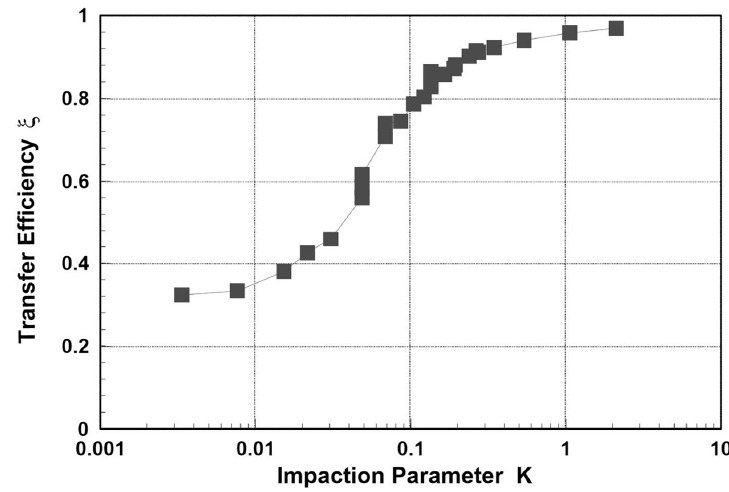
Figure 4. Spray transfer coefficient ξ against the impaction parameter K (adopted from [29]).